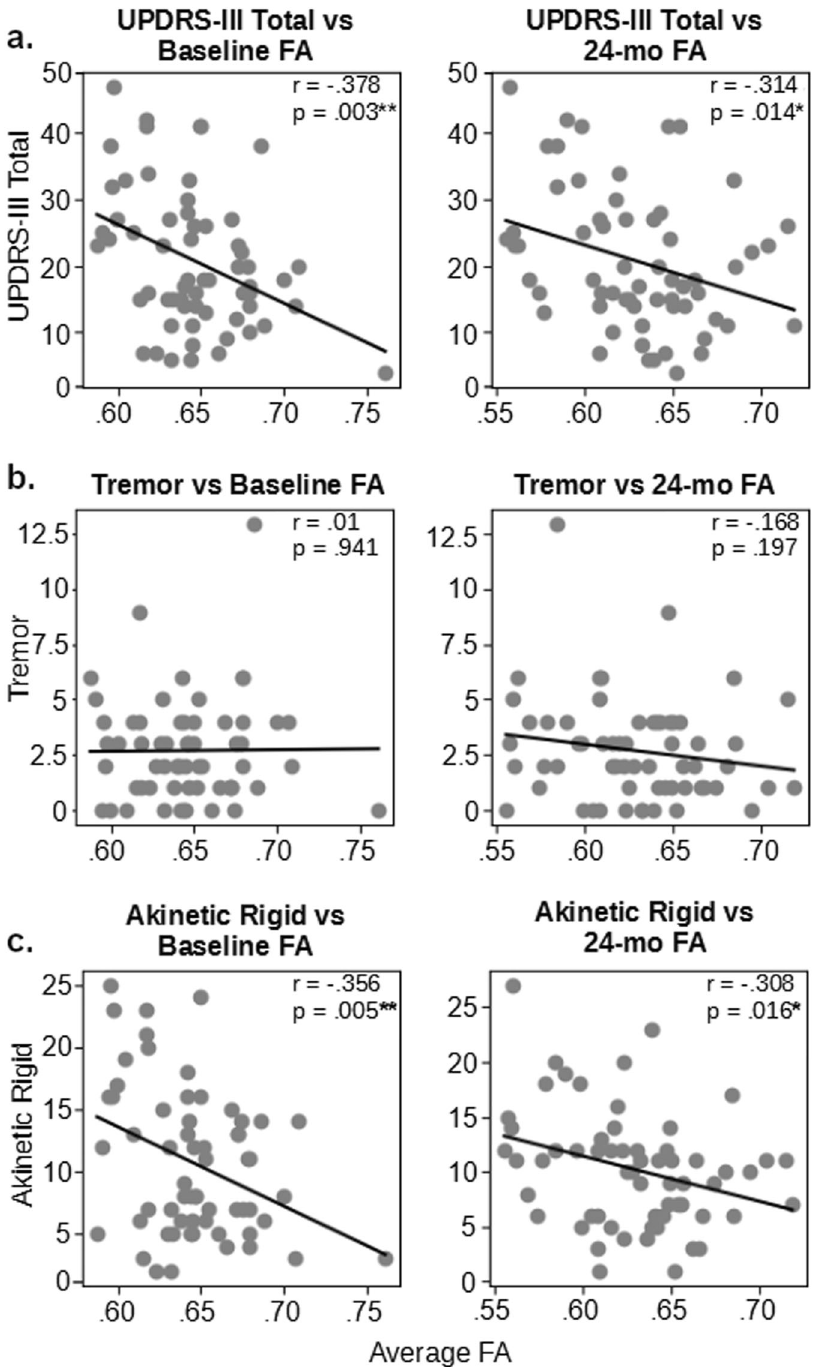
Fig. 4 UPDRS-III total and akinetic-rigid scores are associated with FA of the full corpus callosum at both time points. Scatter plots in the left show across-subject correlation between motor symptoms and baseline CC FA and those in the right show the correlation with 24-months FA. a The bivariate relationship between baseline and 24-month UPDRS-III with baseline CC FA. b The bivariate relationship between baseline and 24-month tremor UPDRS-III subscores with baseline CC FA. c The bivariate relationship between baseline and 24-month akinetic-rigid UPDRS-III subscores with baseline CC FA. Annotations: * p < 0.05; ** p <